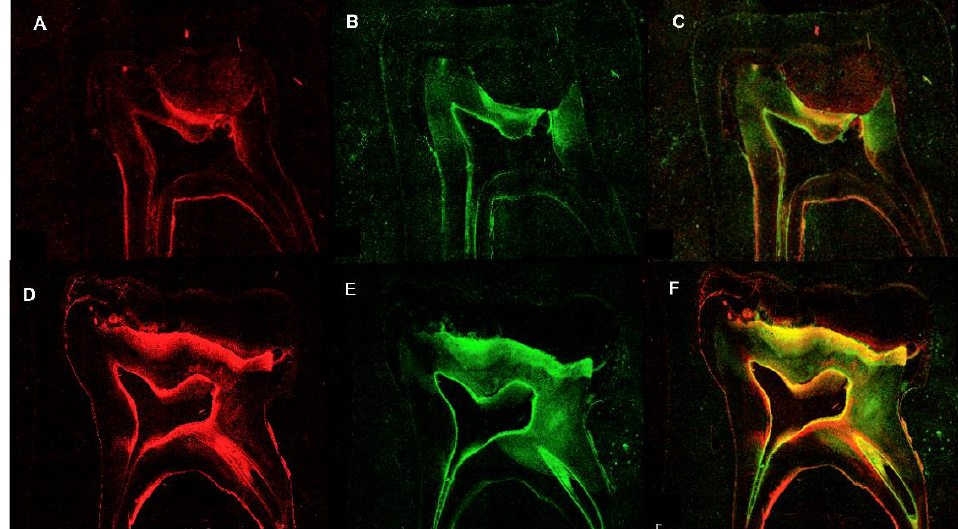
Figure 3. (A – F ): Confocal laser scanning microscopy images of bacterial colonization. The infected dentin was stained with a LIVE (green)/DEAD (red) BacLight Bacterial Viability Kit and analyzed using the LAS AF software. ( A – C ) Conventional technique, ( D – F ) Hall technique.